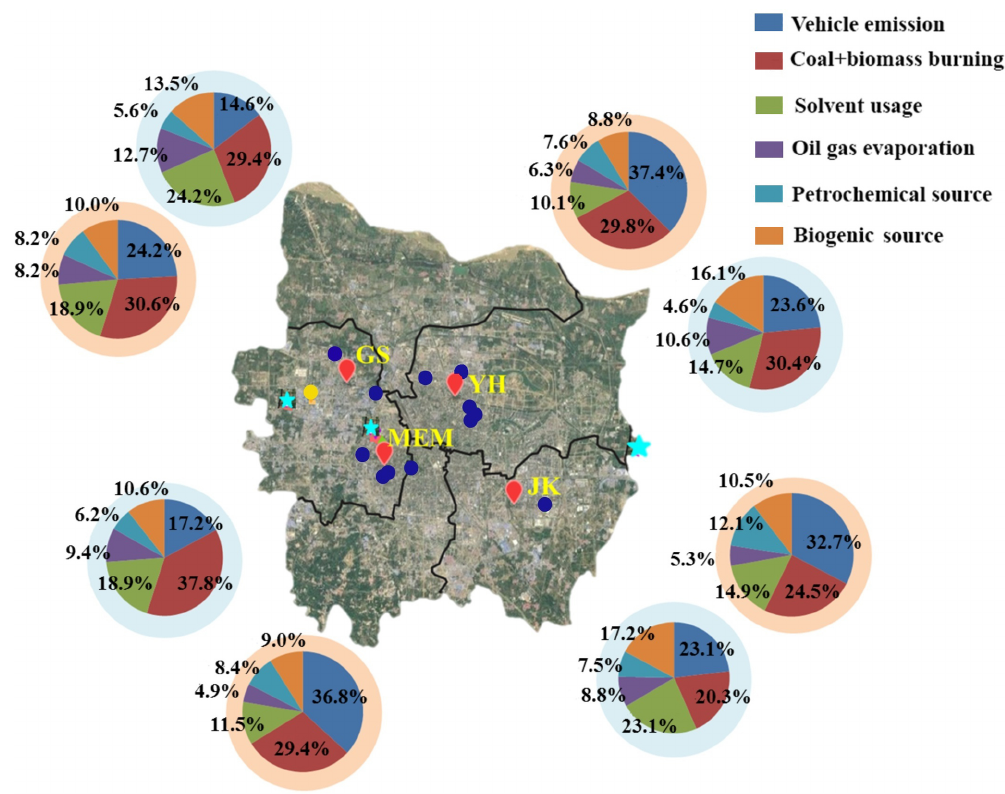
Figure 17. Source apportionment results during the whole sampling period. The results weighted by observed concentrations are shaded in pink, and the results estimated based on OFP are shaded in light blue.